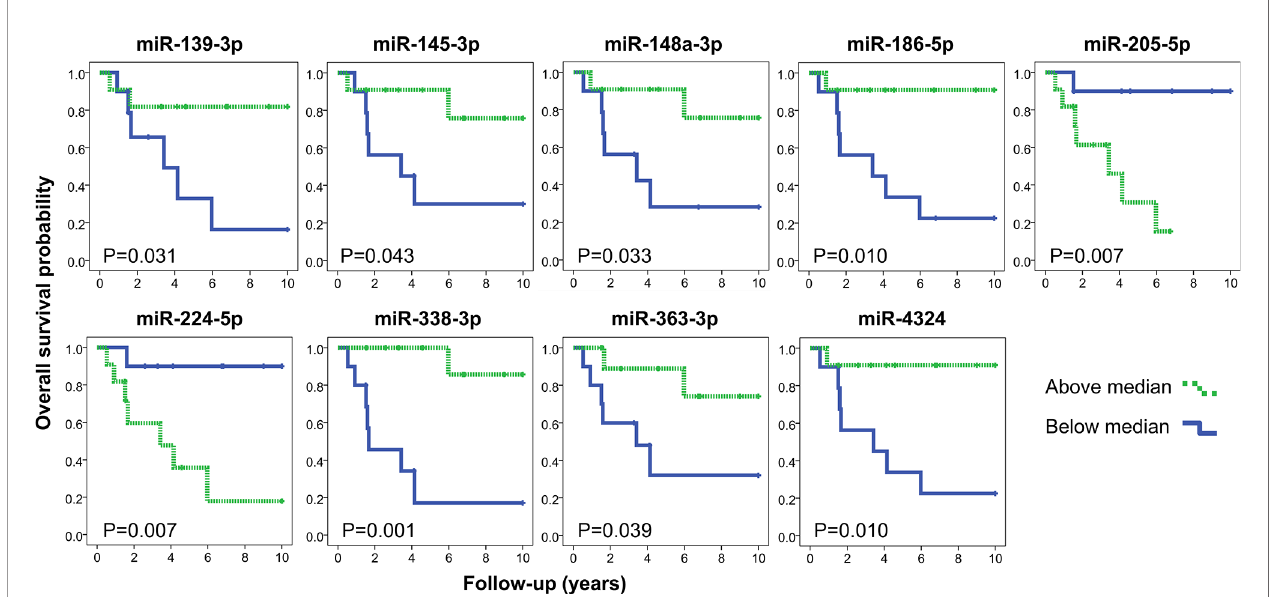
FIGURE 4 | Kaplan-Meier representation of overall survival according to the expression levels of nine miRNAs (log rank test P<0.05). The quanti fi cations obtained by the microarray analysis were strati fi ed in below (blue) and above (green) the median values. Note: miR-224-3p was omitted (both mature sequences from mir-224 precursor were associated with overall